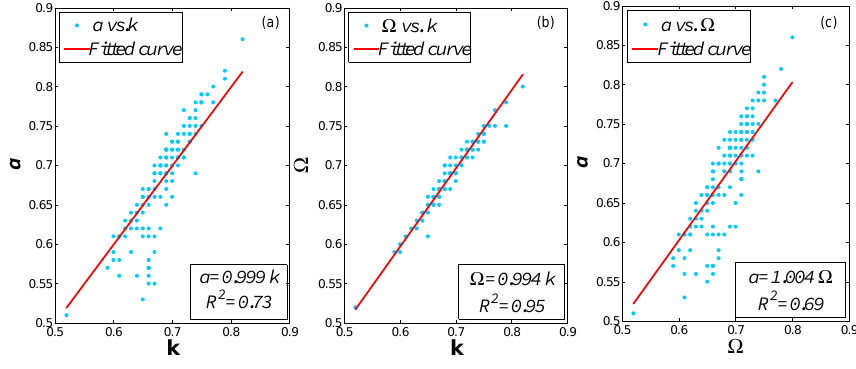
Figure 9. Relationship between k (Eq. 9), a (Cheng et al., 2011) and (cid:127)